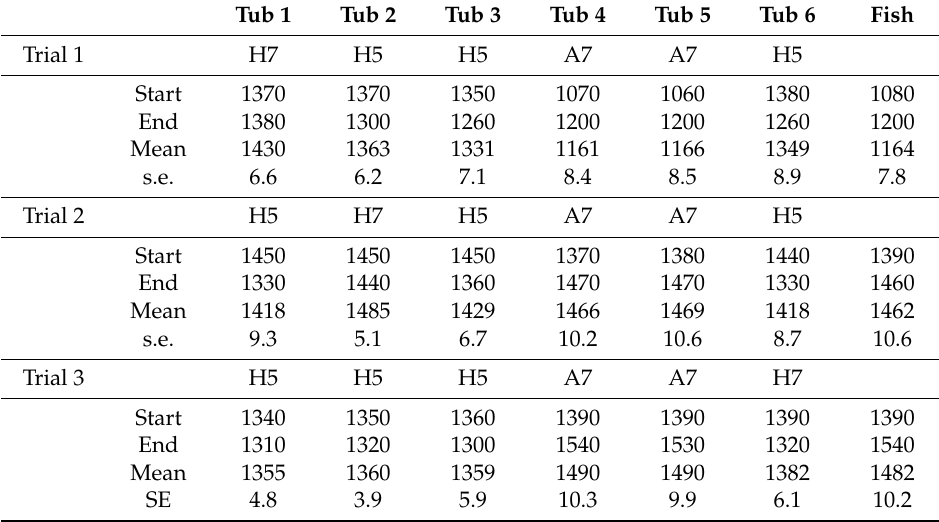
Table 5. Electroconductivity (EC, µ S/cm) starting, ending, mean, and standard error (SE) for each trial and tub with treatment imposed on each tub; summary of treatments by tubs by trial is also shown for